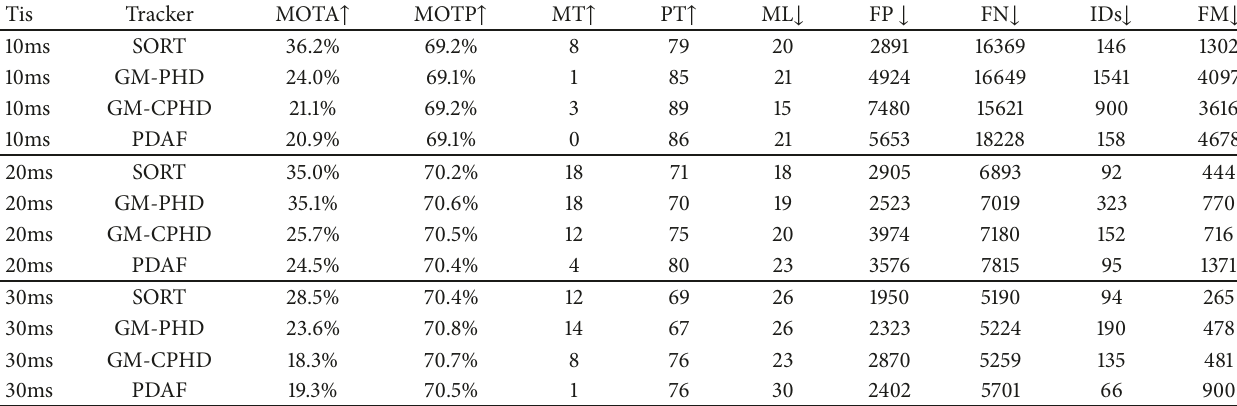
Table 4: The tracking performance for EventSeq-Vehicle1 using different tracking methods (SORT, GM-PHD, GM-CPHD, and PDAF) with detection through DBSCAN clustering. The impact of time intervals from 10ms to 30ms was studied.